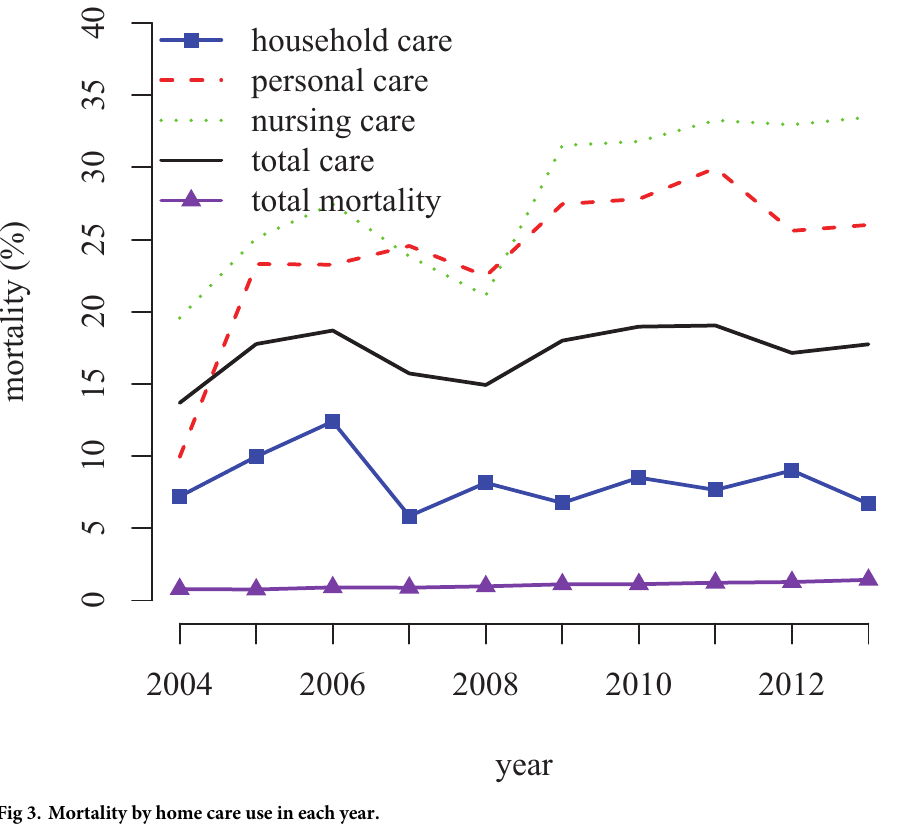
occupation measures the socio-economic position of the household at age 18. Intelligence, as measured by an IQ-test, affects both health [18–20] and the take-up rate of home care use. We do not include the education level, because education is likely to be an endogenous variable. The quadratic trend in the month of birth is included to capture the age effect on home care Table 2. Odds ratios panel probit model of unfit for service at military examination on later life home care use. Household Personal Nursing Total 2.230 �� 1.138 + 1.129 �� 1.259 �� (0.216) (0.062) (0.047) (0.059) Accounting for selective survival 2.186 �� 1.118 �� 1.109 �� 1.229 �� (0.207) (0.047) (0.036) (0.051) Average prevalence 1.06% 1.20% 1.21% 2.31% Also included are a quadratic trend in the birth date, period dummies for the home care observation year and care purchasing agency region dummies, father’s occupation and IQ-measurement. All analyses weighted by the sampling weights. + p <